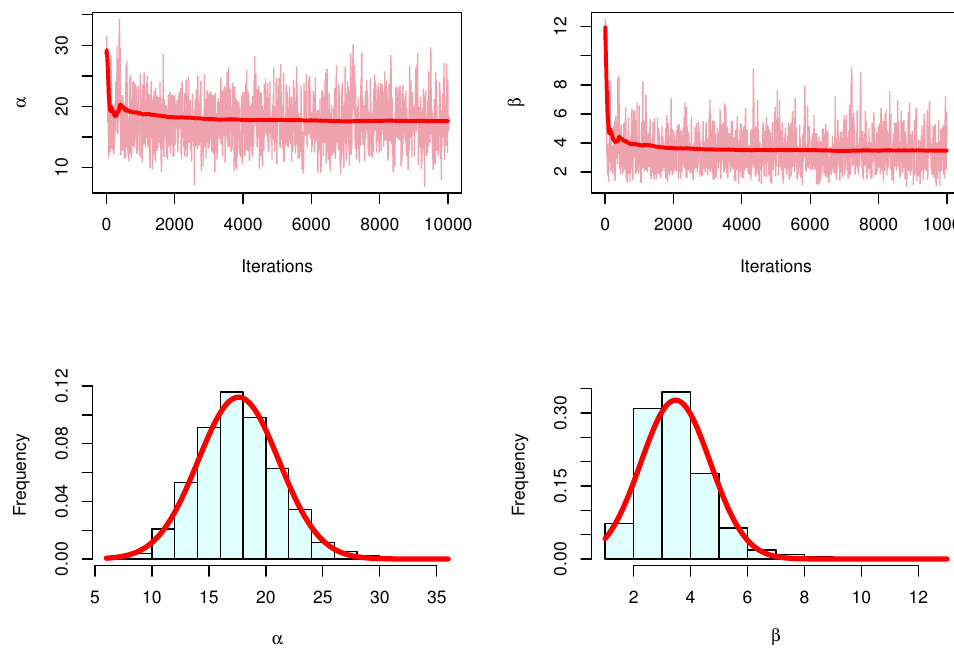
Figure 11. Trace and posterior density with normal curve for MCMC results: Data II.